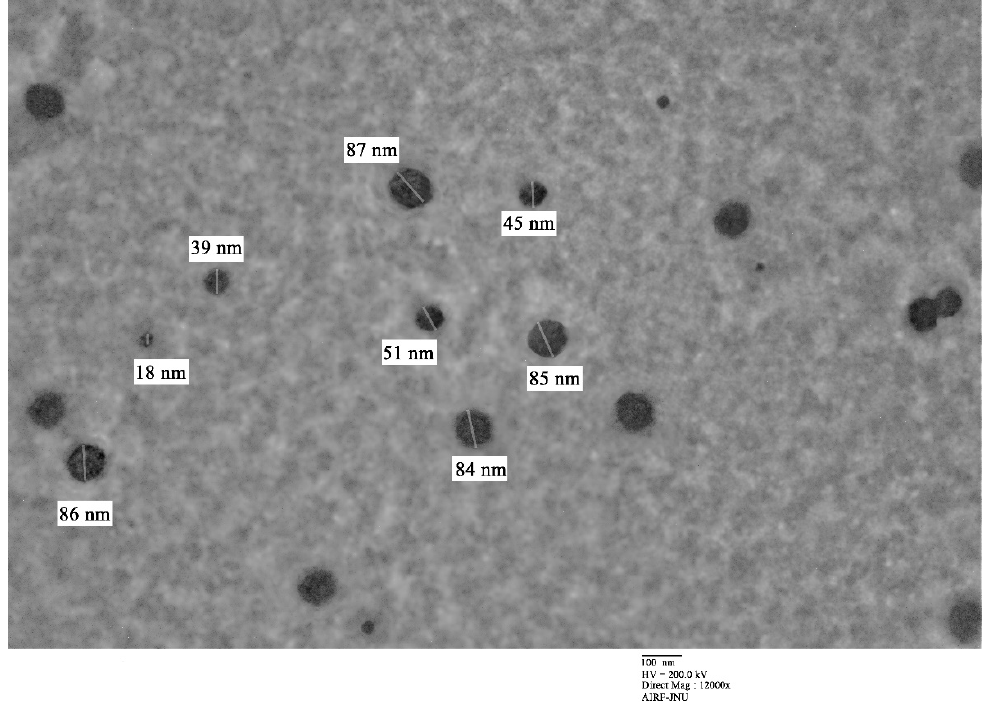
Figure 4. Micrograph showing TEM analysis of APO-NPs at a 100 nm scale of 10,000 × magnification.